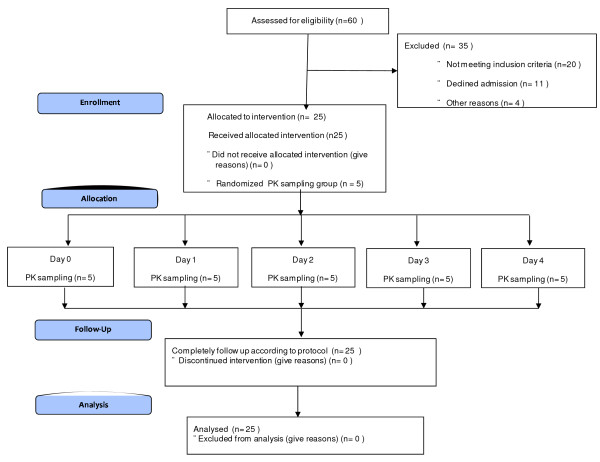
Study flow chart.